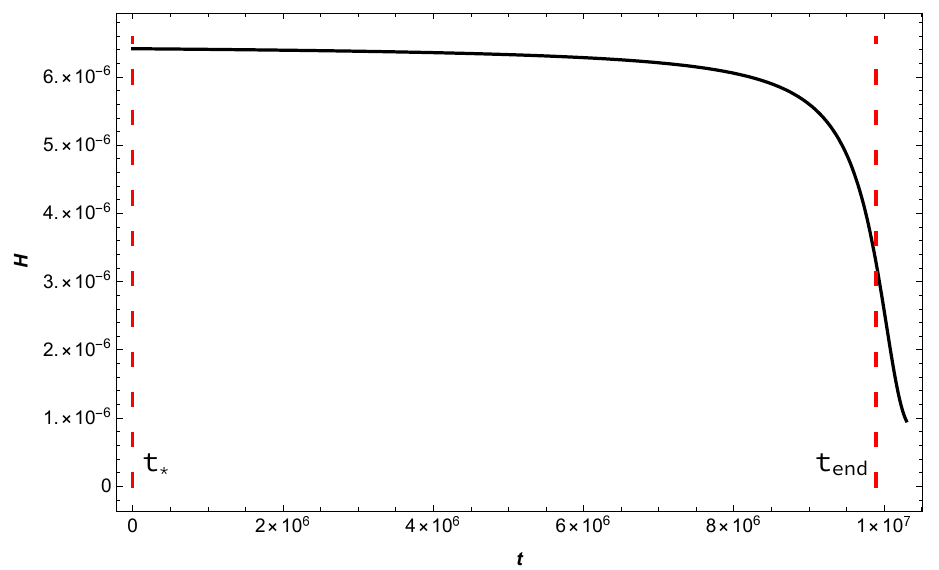
Figure 2. The black line displays the evolution of the Hubble parameter H . In(cid:13)ation begins at t (cid:3) = 0 and ends at t end ’ 9 : 89 (cid:2) 10 6 . We have set M P =